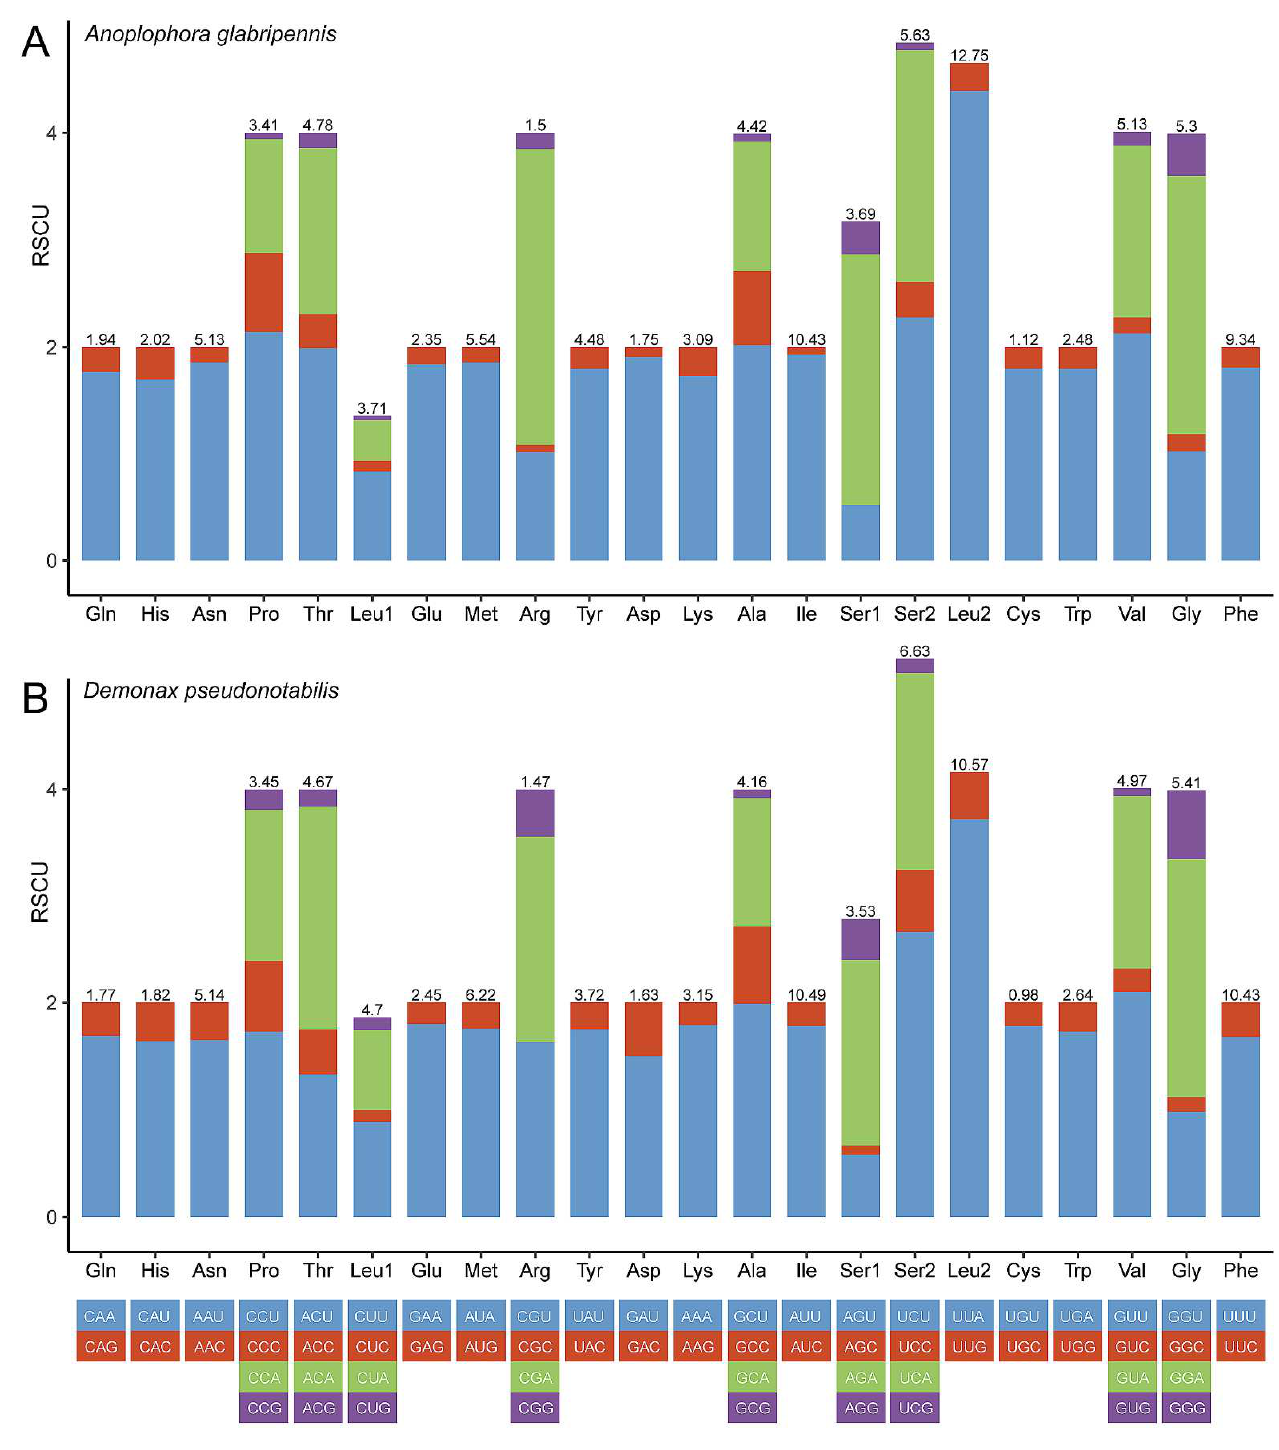
Figure 2. Relative synonymous codon usage (RSCU) of PCGs in A. glabripennis ( A ) and D. pseudono- tabilis ( B ).